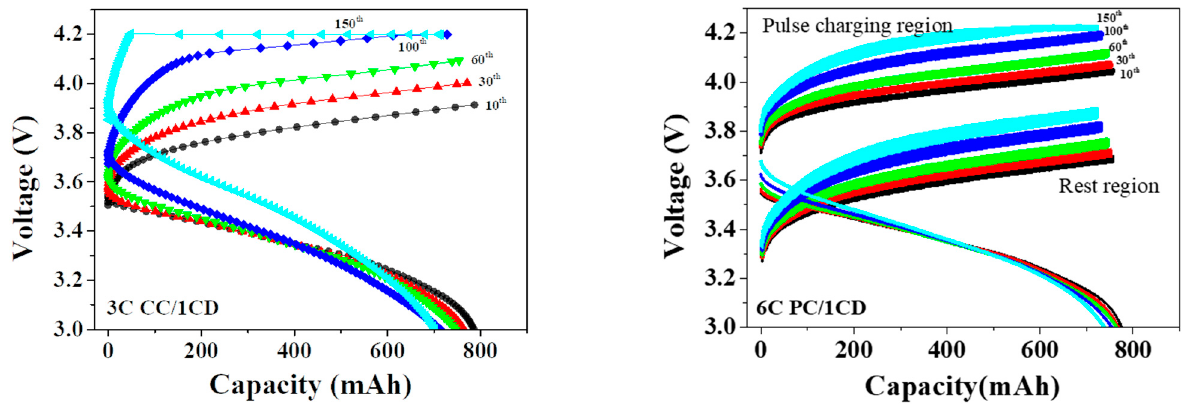
Figure 4. Voltage-capacity profile at selected